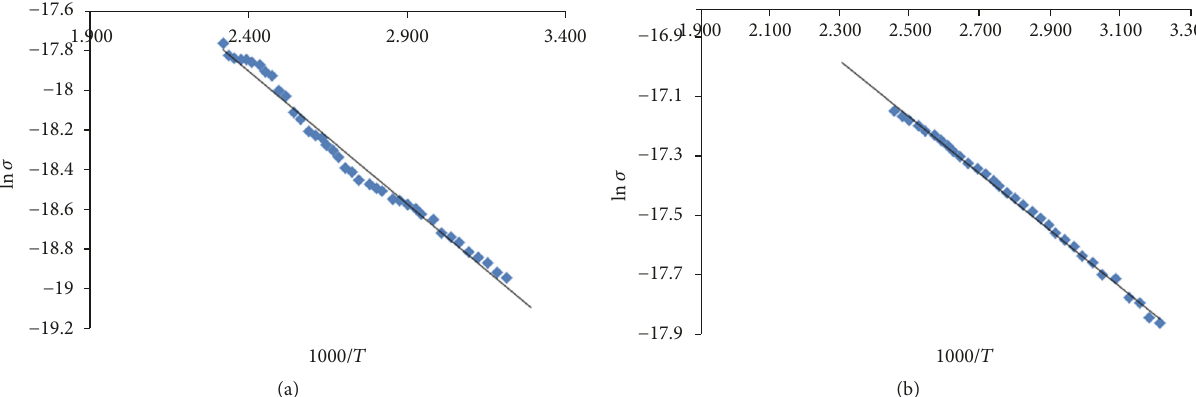
Figure 19: The graph of the conductivity (ln 𝜎 ) with 1000/ 𝑇 temperature for (a) P(DEAMSt0.11-co-MMA) and (b)